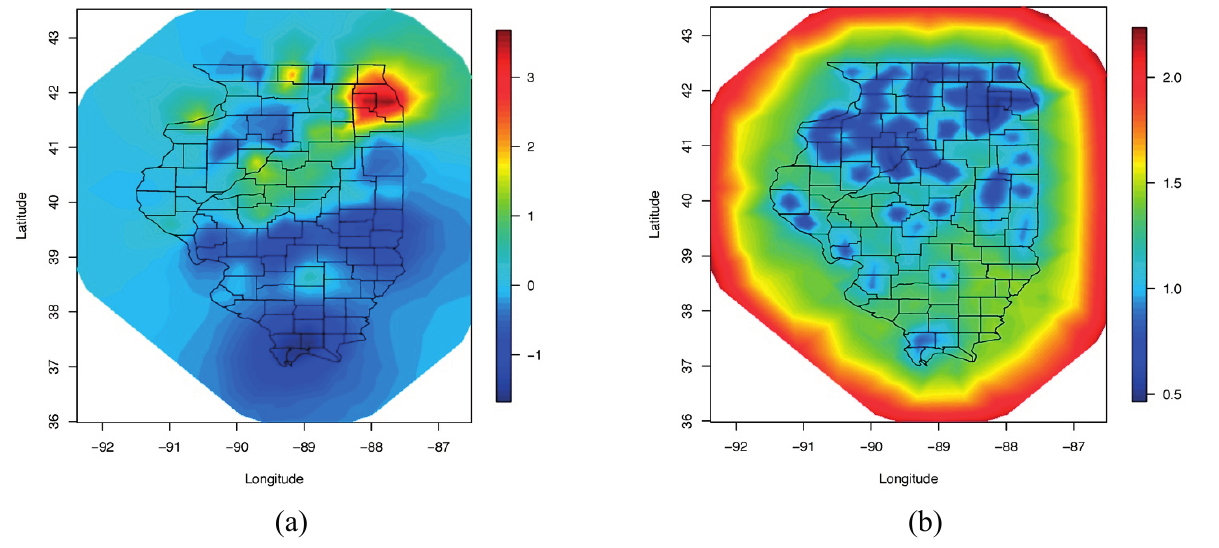
Figure 3. Spatial fields ( a ) posterior mean, ( b ) posterior standard